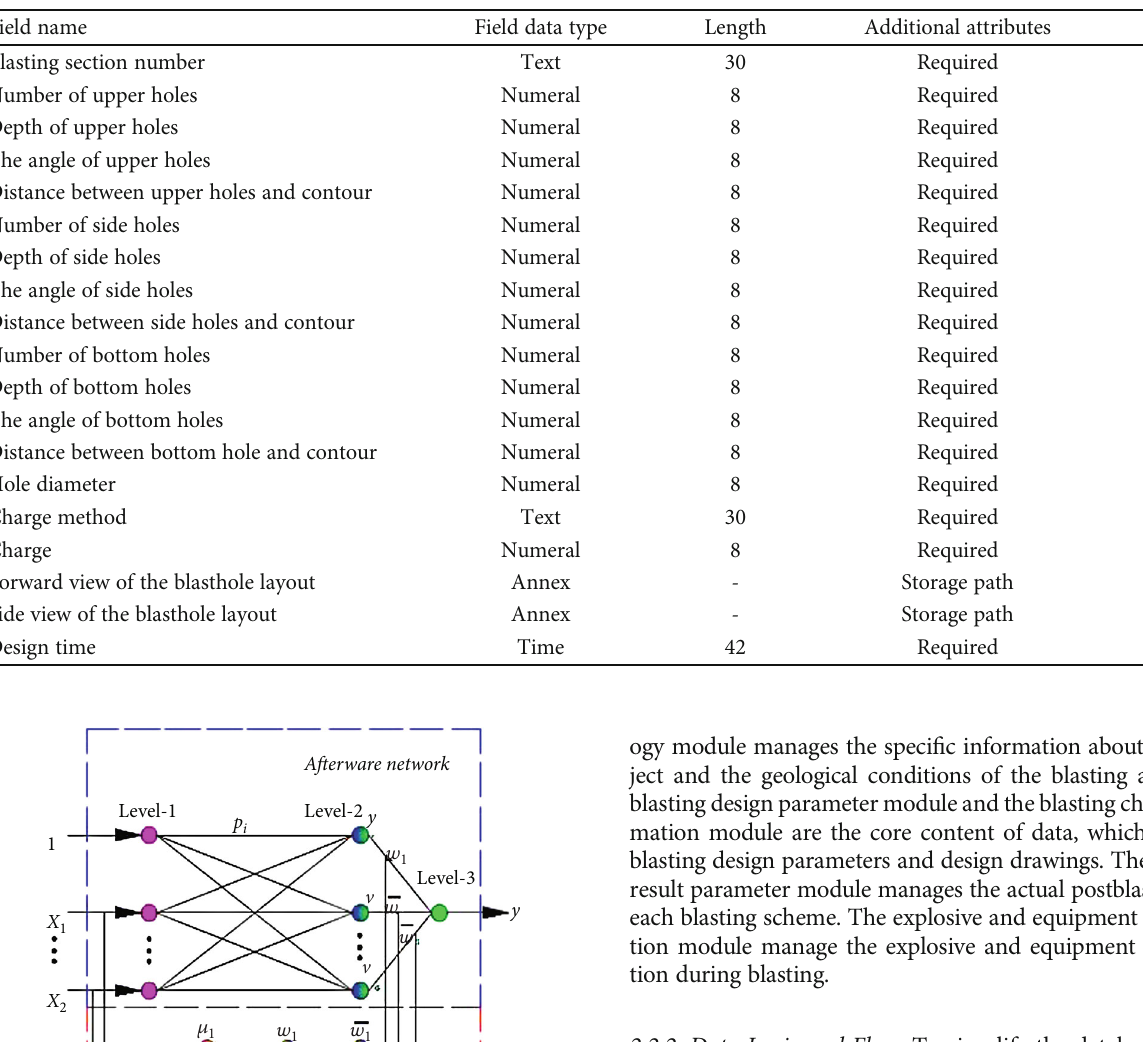
Table 2: Design parameters of the peripheral hole.